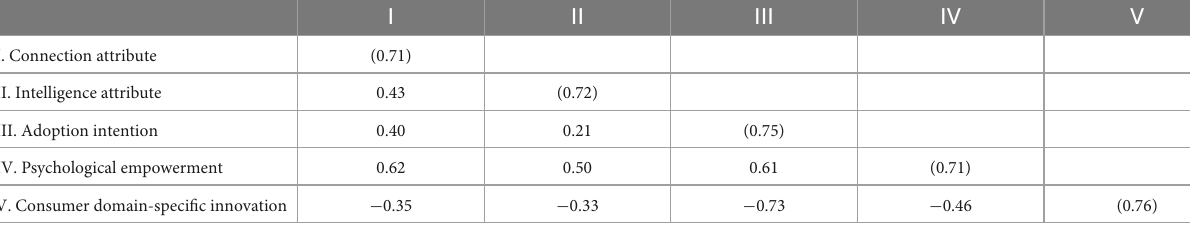
TABLE 2 Construct correlation values and comparison with average variance extracted